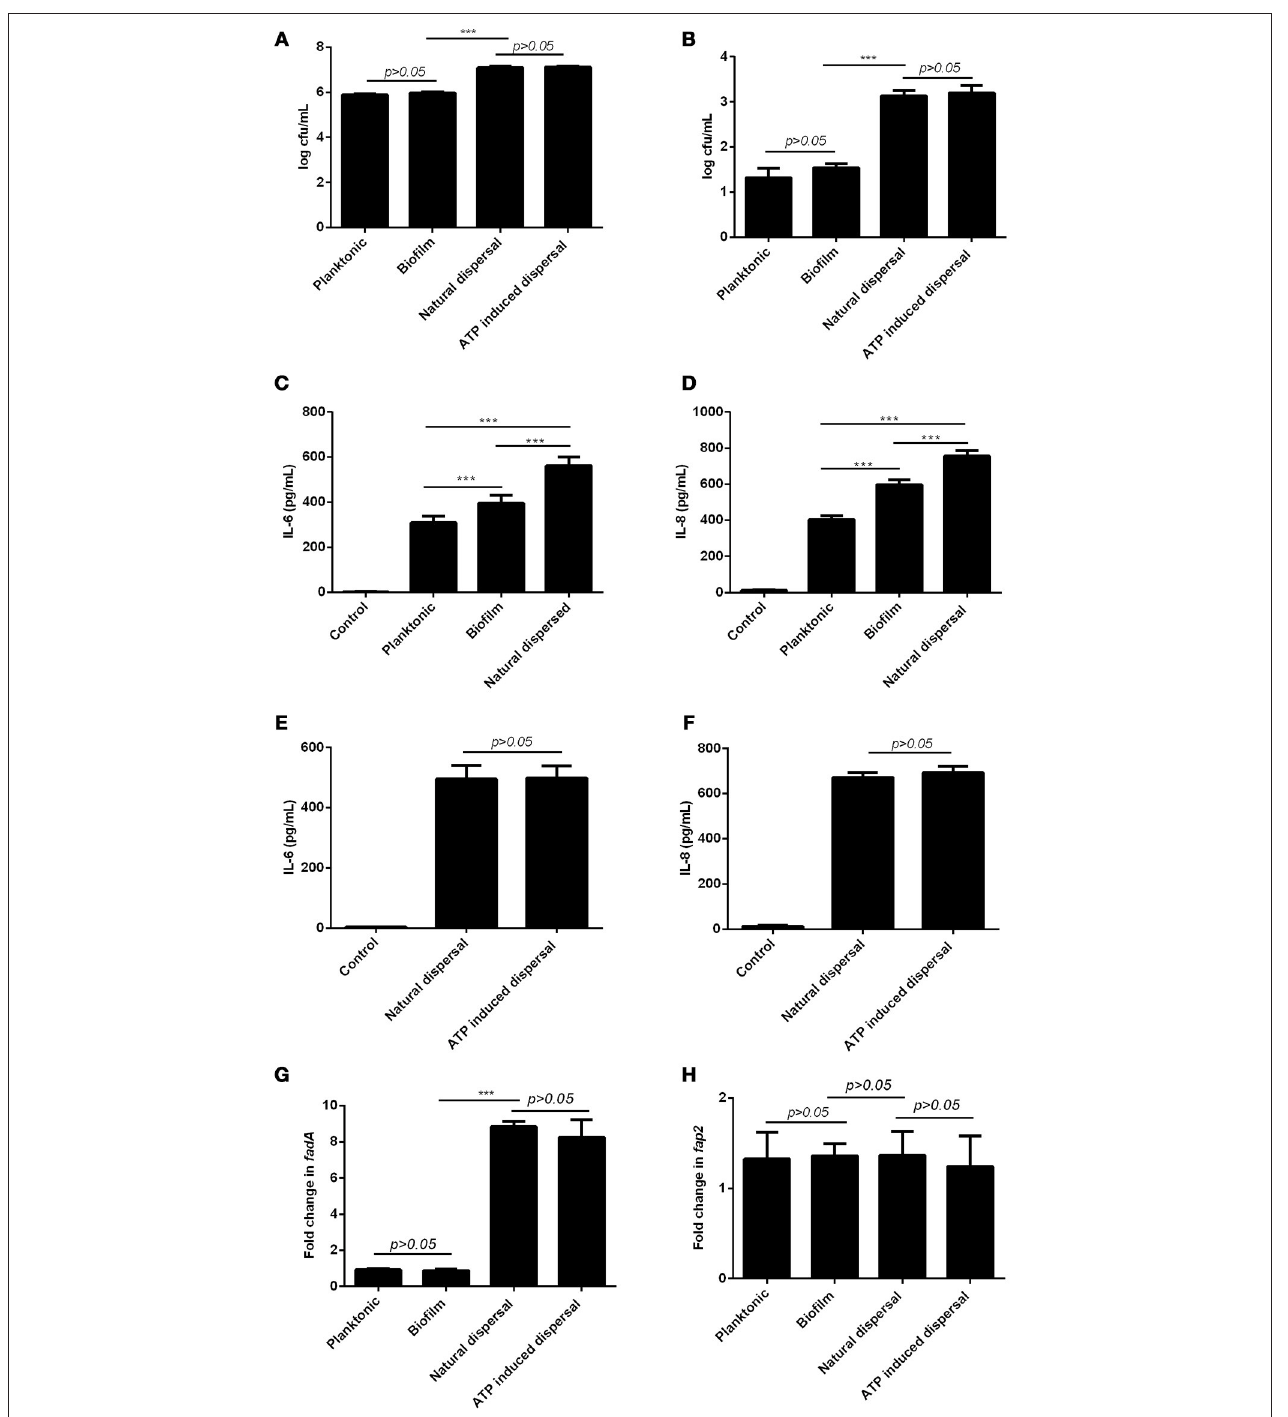
FIGURE 3 | Differential effects of planktonic, biofilm and dispersed F. nucleatum on periodontal fibroblasts. Primary periodontal fibroblasts were infected with planktonic, biofilm, naturally dispersed or ATP induced F. nucleatum for 1h after which (A) cell-associated bacteria and (B) intracellular bacteria were determined by serial dilution and plating. Periodontal fibroblasts were infected with planktonic, biofilm, naturally dispersed or ATP induced F. nucleatum for 4h and the amounts of (C,E) IL-6 and (D,F) IL-8 produced were quantified by ELISA. The expression of (G) fadA and (H) fap2 in planktonic, biofilm and dispersed F. nucleatum were determined by qPCR. *** p <